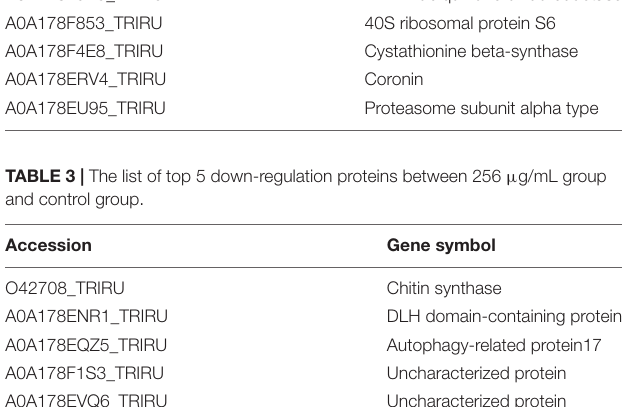
TABLE 2 | The list of top 5 upregulation proteins between 256 µ g/mL group and control group.